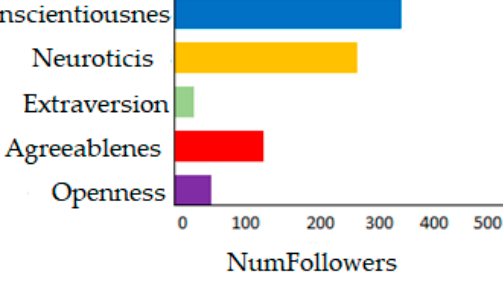
Figure 5. Identification of the number of followers by user personality trait.